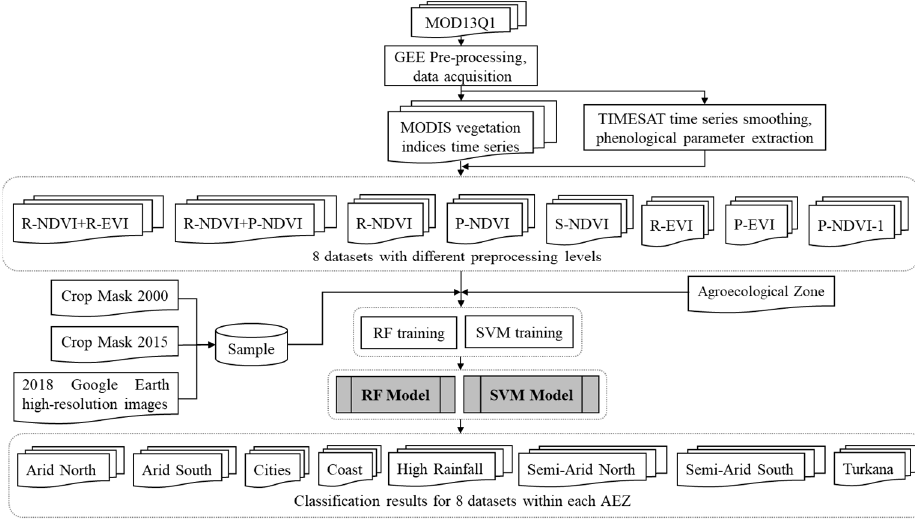
Figure 2. Graphical scheme of classification process in this study.